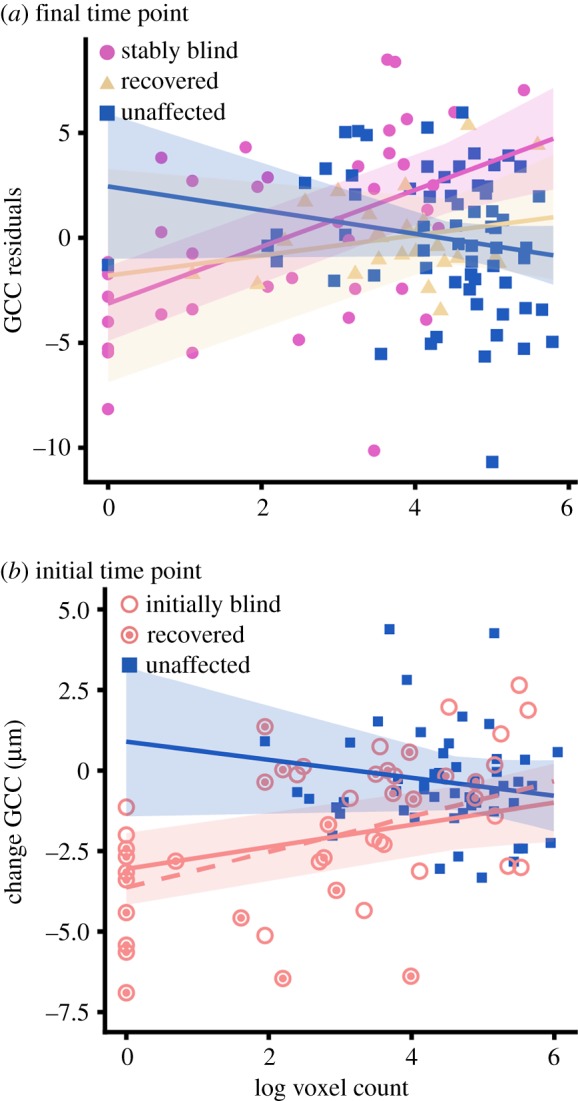
GCC thickness is associated with visual cortex activity. (a) GCC thickness at the final time point, controlling for change in visual ability over time, is related to the number of voxels in which there is stimulus-evoked activity for stably blind areas of the visual field at the final time point (n = 13; pink circle, stably blind; yellow triangle, recovered; blue square, unaffected). (b) The number of voxels that respond to stimulation of the initial blind field (red circle) but not the unaffected areas of the visual field (blue) at the initial time point (less than two months post-stroke) predicts the change in GCC thickness at the final time point (five+ months post-stroke, n = 10). This relation remains when wedge locations that recover vision are removed from the analysis (dashed red line; open red circle, recovered; filled red circle, stably blind). Error is 95% confidence interval. (Online version in colour.)